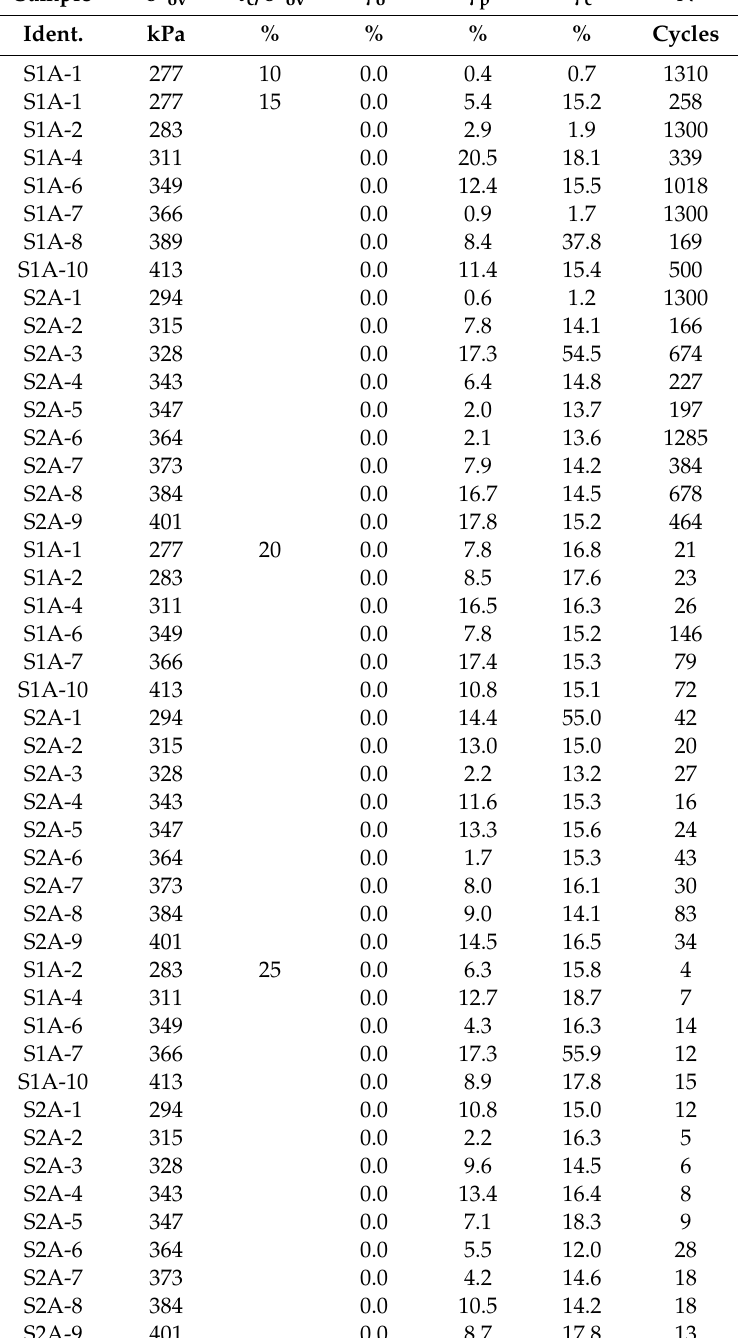
Table 4. Results of cyclic simple shear test with τ o / σ (cid:48) ov =